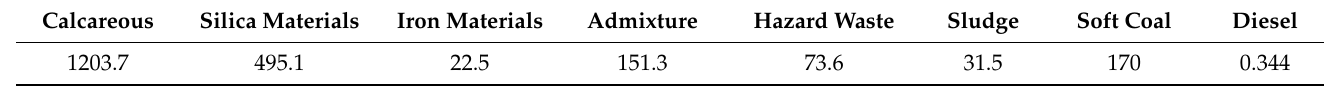
Table 1. Activity level of the co-processing cement